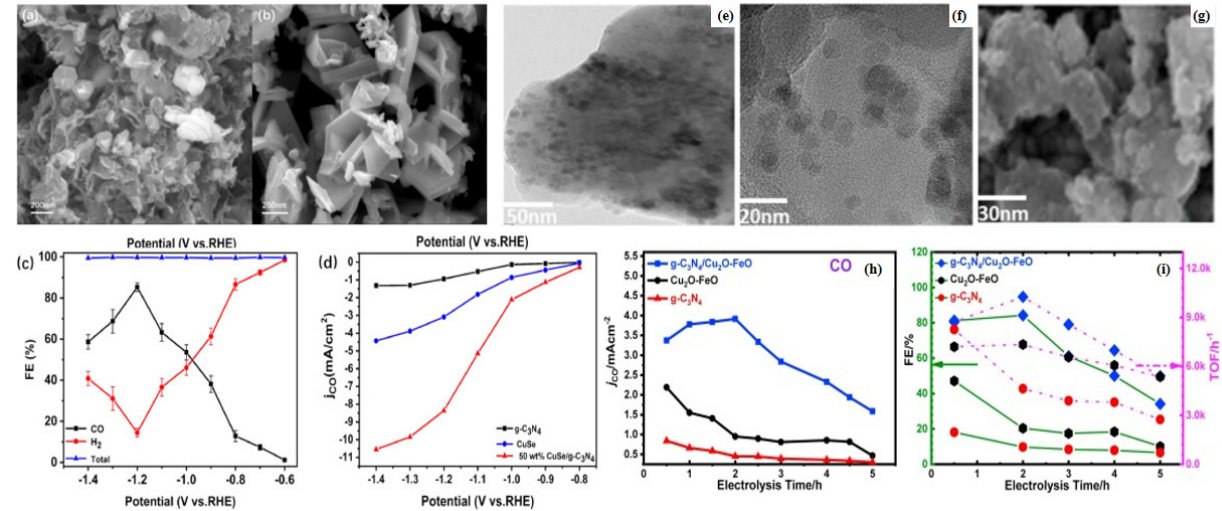
Figure 7. ( a ) 50% CuSe/g-C 3 N 4 SEM images; ( b ) CuSe nanoplates SEM images; ( c ) Faraday efficiency plots of 50% CuSe/g-C 3 N 4 ; ( d ) Partial CO current density of g-C 3 N 4 nanosheets, CuSe nanoplates, and 50% CuSe/g-C 3 N 4 ; reprinted with permission from ref [96], Copyright © 2023 Elsevier Ltd. HRTEM images of g-C 3 N 4 /Cu 2 O-FeO: ( e ) 50 nm scale; ( f ) 20 nm scale; ( g ) SEM of g-C 3 N 4 /Cu 2 O-FeO at 30 nm scale; ( h ) Current density of CO when using g-C 3 N 4 /Cu 2 O-FeO; ( i ) Curves of TOF and FE of the products with electrolysis time when using g-C 3 N 4 /Cu 2 O-FeO, Cu 2 O-FeO, and g-C 3 N 4 . The olive solid line indicates FE and the magenta dashed line indicates TOF; reprinted with permission from ref [98], Copyright 2021 Elsevier B.V.